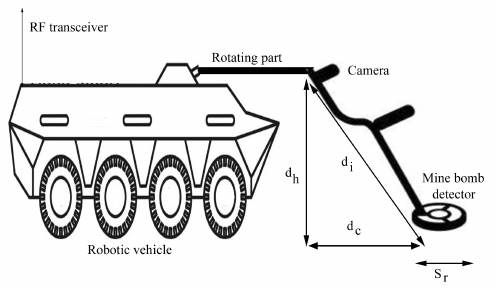
Figure 2. Robotic vehicle with sensor